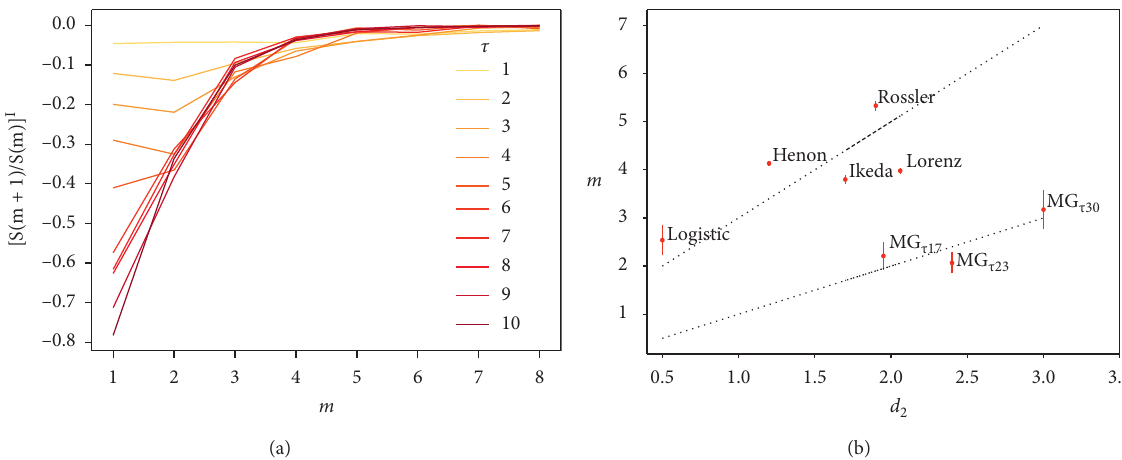
( m + 1 )] / S [ M ( m )] as a X X . For each 2 ; 2